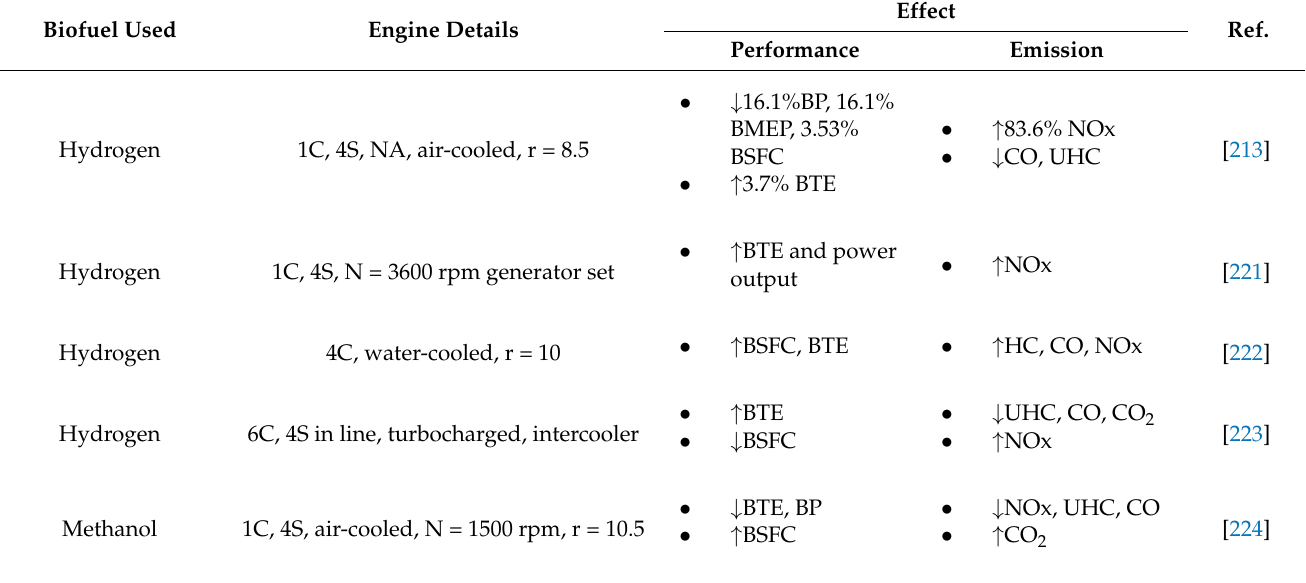
Table 13. Effects of alcohol, biogas, and hydrogen as alternative fuels for SI engines. Biofuel Used Engine